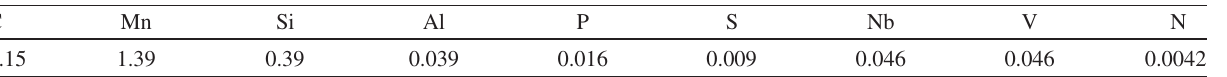
Table 1. Chemical composition of the steel (wt%).